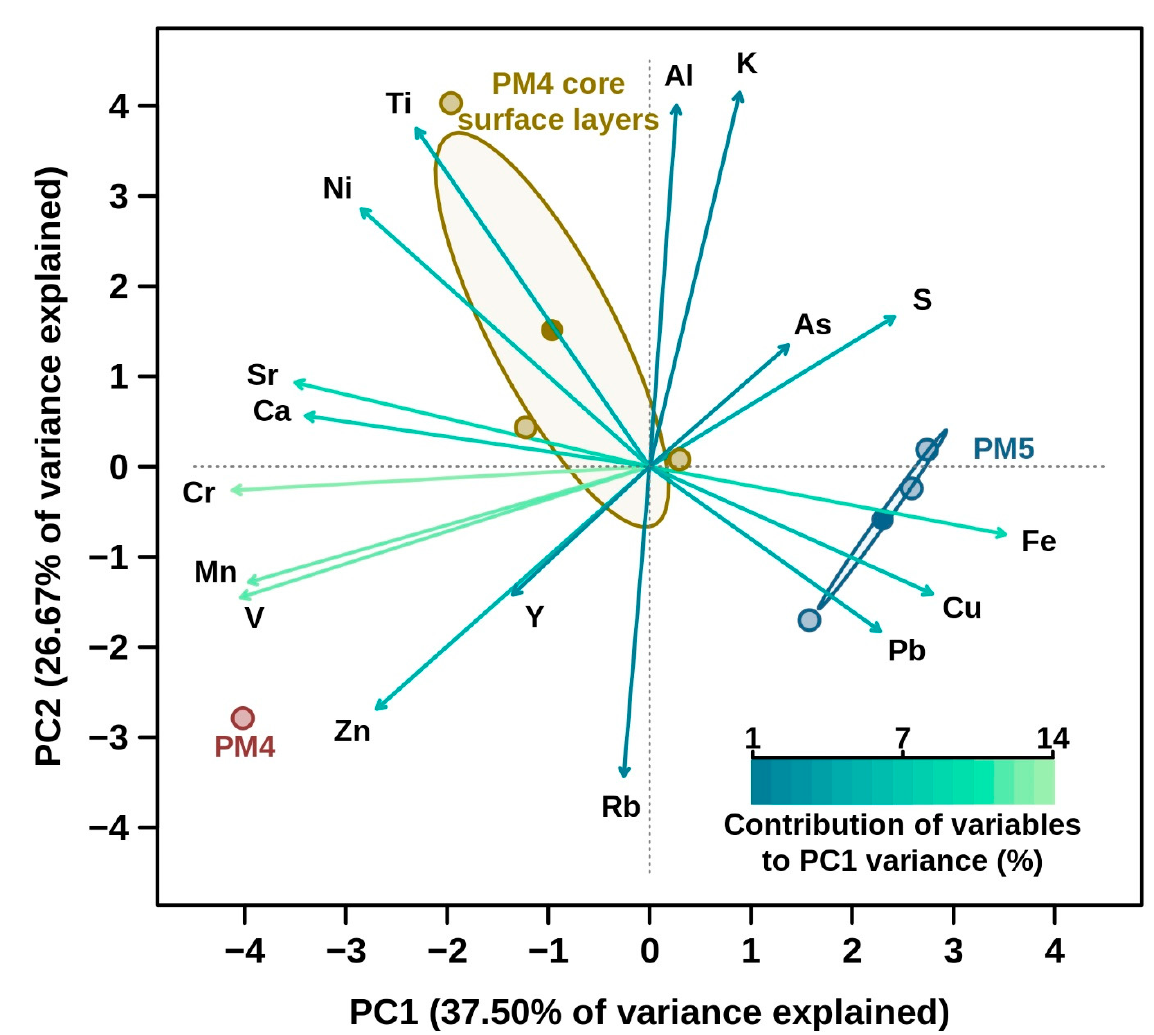
Figure 2. Principal component analysis (PCA) representing the abundance profiles of different metals present in the two analysed Parys Mt sites (PM4, red circles; PM5 blue circles), including, additionally, samples from the core surface layers (yellow circles) collected from PM4 sediments [13]. Ellipses are drawn for PM4 surface core samples (yellow) and for PM5 samples (blue) based on the samples’ variance. Corresponding dots are based on samples’ means. The contribution (%) of each metal to samples’ separation over PC1 (X axis) is shown by the arrows (colour key is shown in the bottom right).